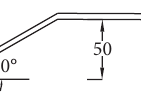
Figure 2: Specification of the corrugated